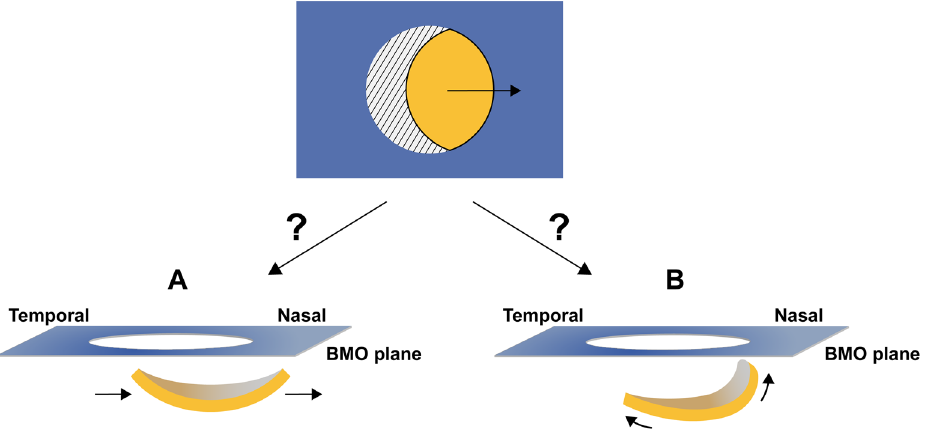
Figure 1. Schematic illustration of hypothetical three-dimensional view of LC in myopic optic nerve head. The above image depicts myopic optic disc, well-known as ‘tilted disc,’ in a two-dimensional view. This ‘two- dimensional tilted disc’ may be, in the three-dimensional view, either ( A ) tilt-like disc appearance or ( B ) real disc